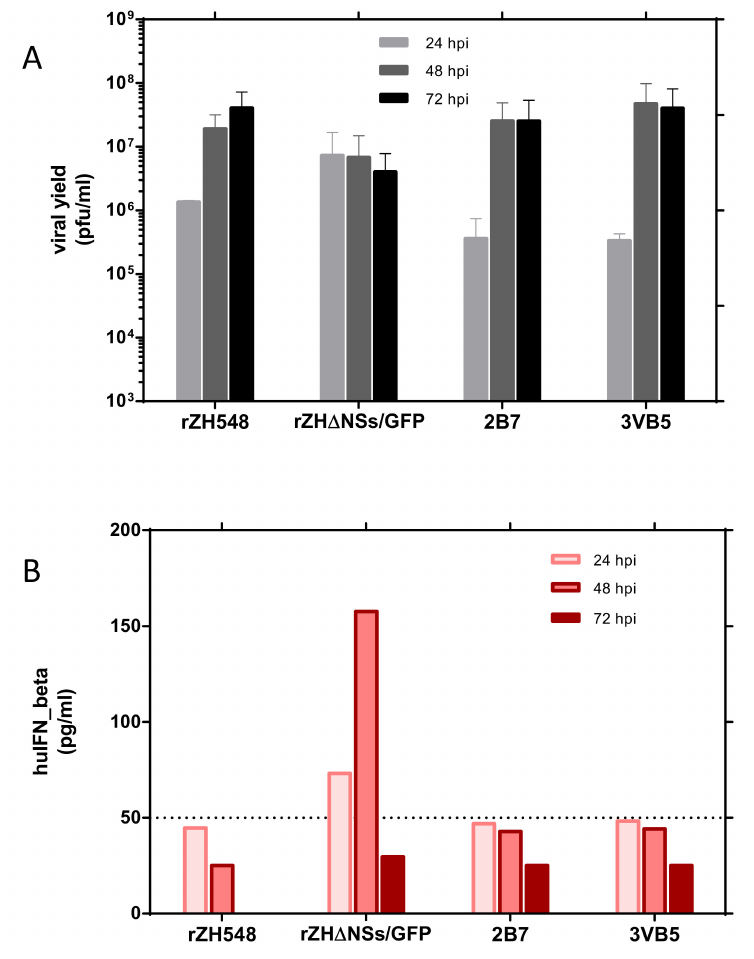
Figure 4. Growth of rZH548-P82L mutants on HEK293T cells and IFN- β production. HEK293T cells were infected at a MOI of 0.05 with the indicated viruses. At 24, 48 and 72 hpi, supernatants were collected and titrated on Vero cells (panel A ) and analyzed for IFN- β production by ELISA (panel B ). The limit of detection of this ELISA was established at 50 pg/mL (see Materials and Methods). The sample corresponding to rZH548 at 72 hpi was not analyzed in